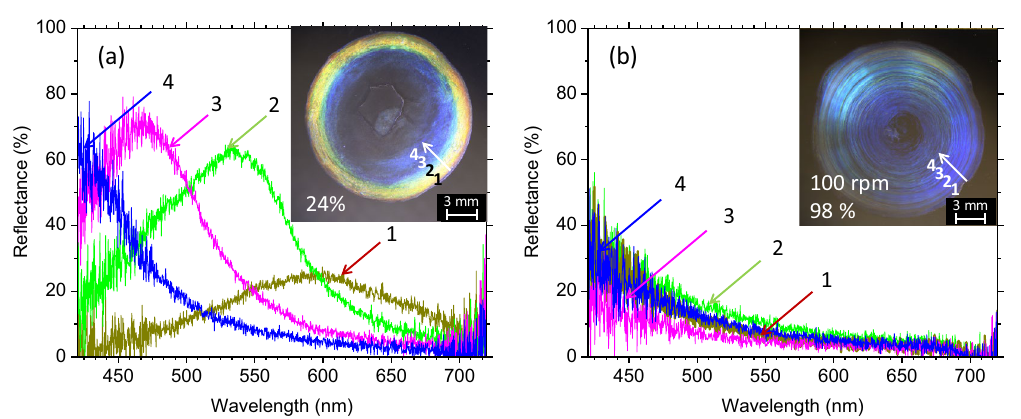
Figure 7. Reflection spectra of 7% CNC droplet films dried at ( a ) 24% humidity without orbital shaking and ( b ) 98% humidity while being orbitally shaken at an anticlockwise rotation speed of 100